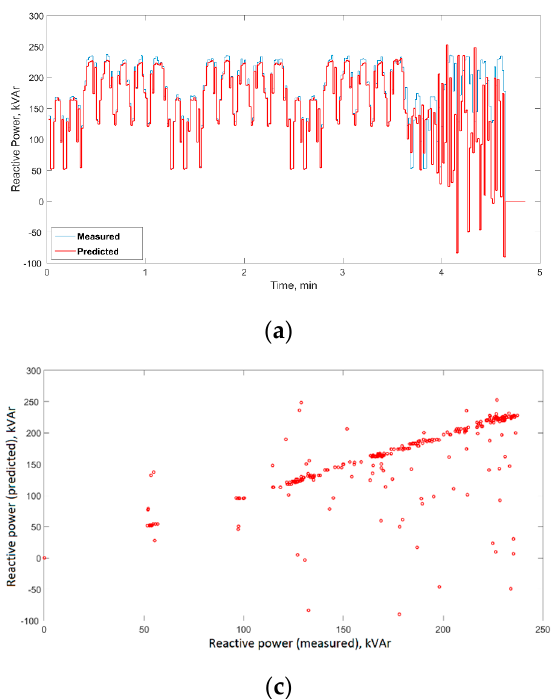
Figure 9. Simulation results for N = 7 neurons, n = 14 samples of the input vector: ( a )–measured and predicted, ( b )–prediction error, and ( c )–predicted vs. measured reactive